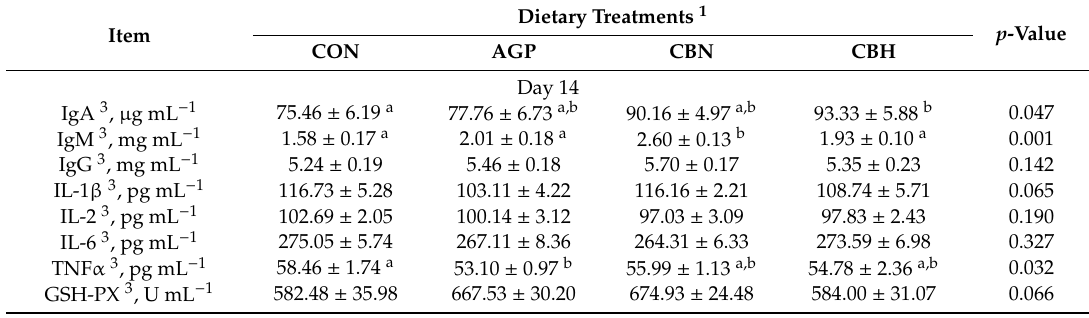
Table 5. E ff ect of dietary C. butyricum on serum immunity and antioxidant ability (mean ± SE 2 ).